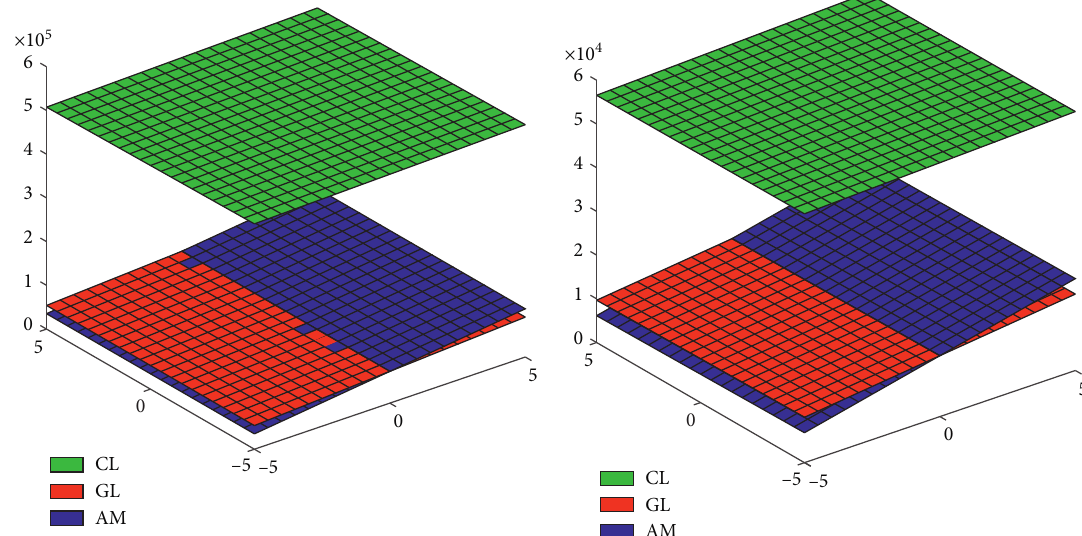
Figure 9: Comparison of CL l connectivity index.